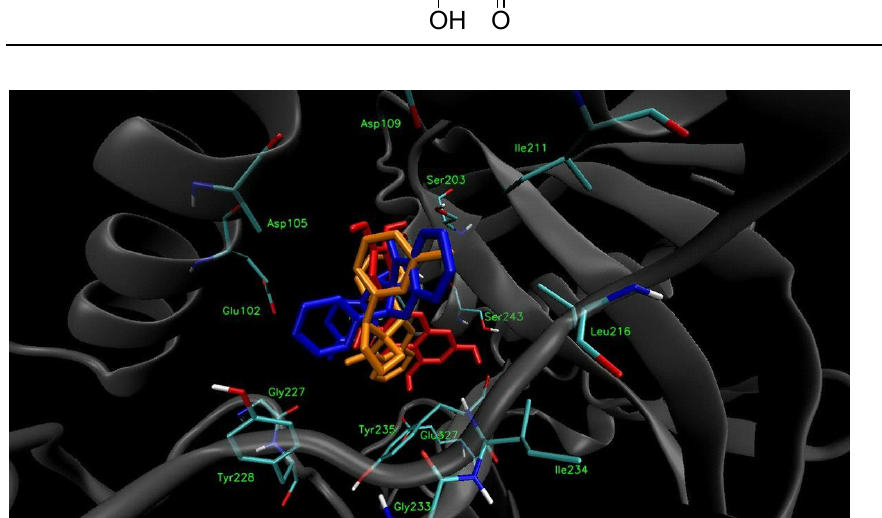
Figure 6. Docked binding modes of compound I (orange) and II (blue), and quercetin (red) to the PARP1 enzyme’s active site.